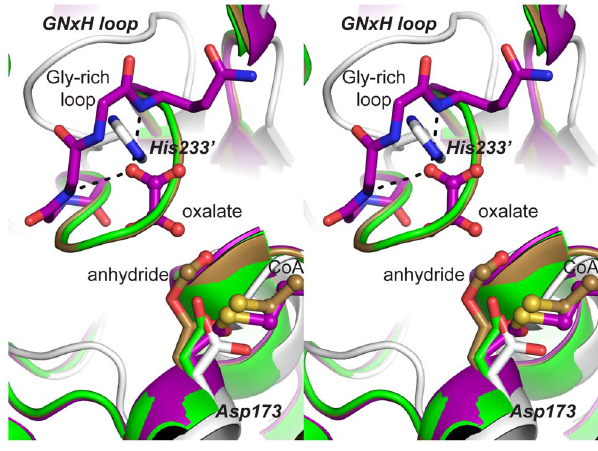
Figure 6. Stereogram of FCOCT and ACOCT active sites. Superposition of H6YfdE structure (gray, PDB entry 4hl6) on several O. formigenes FRC structures: apo (green, PDB entry 1p5h) [69], aspartylformyl anhydride adduct plus CoA (light brown, PDB entry 2vjm) [20], and aspartyl-CoA thioester adduct plus oxalate (purple, PDB entry 2vjo) [20]. Bold italic letters identify significant features in the